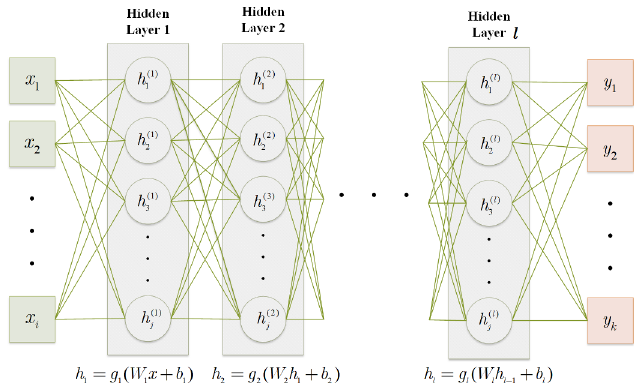
Figure 2: Deep feedforward neural